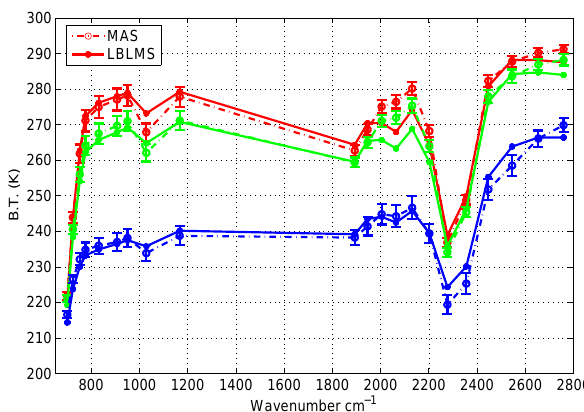
Fig. 14. IR brightness temperature from LBLMS simulated and MAS observed radiance at 20km. The three colours represent the three sections highlighted in Fig. 10. The vertical bars have same meaning as in Fig. 11.